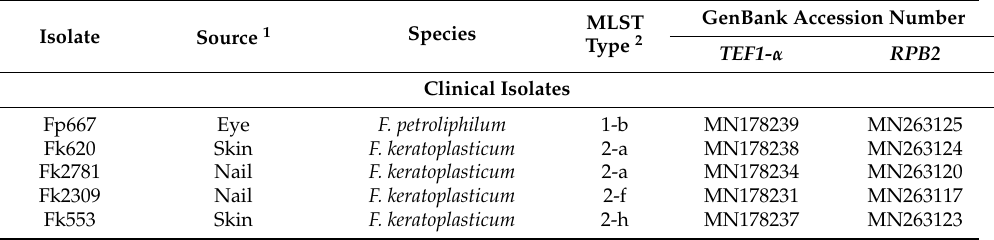
Table 1. List of 15 clinical and 15 environmental FSSC isolates from Malaysia, their MLST type and their GenBank accession numbers for TEF1- α and RPB2